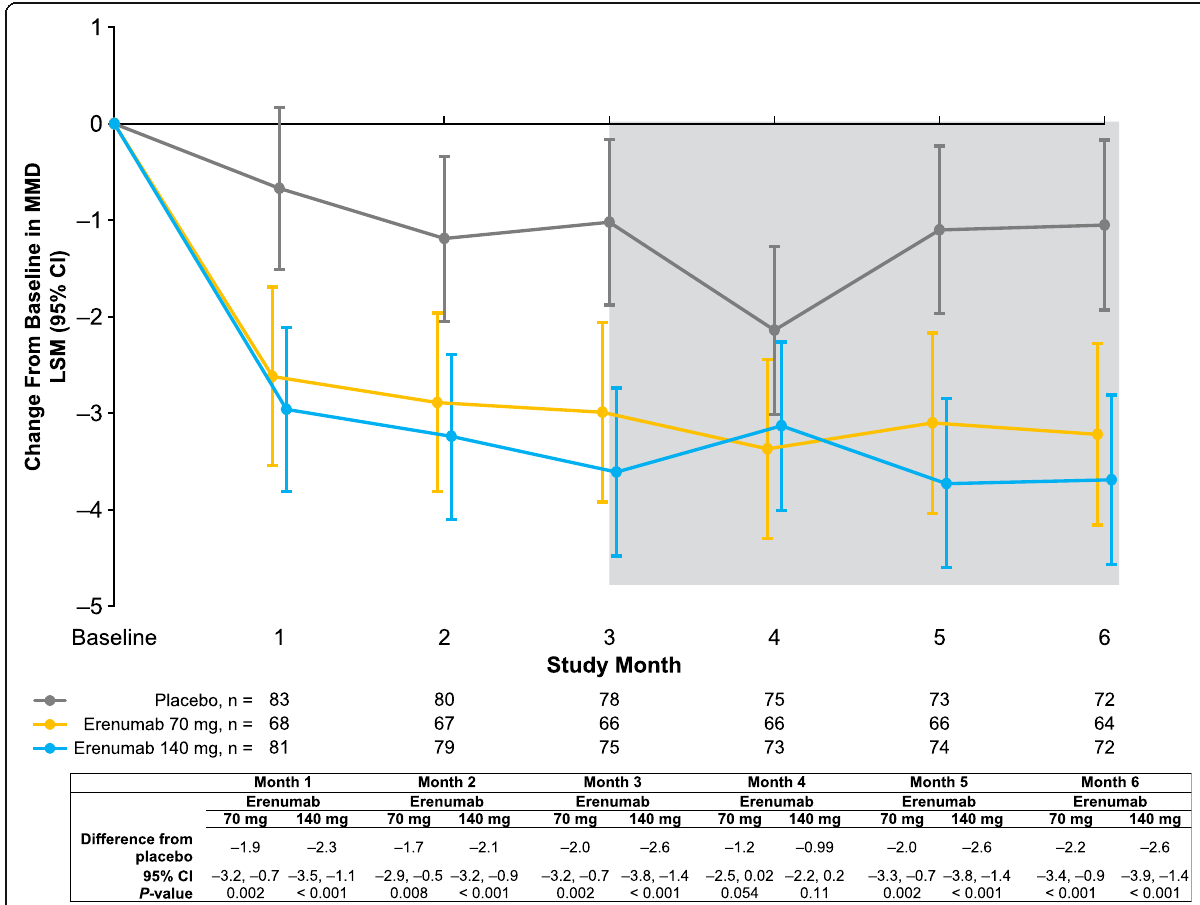
Fig. 1 Change from baseline in MMD. Data are shown as LSM with 95% CIs. The gray shaded area represents months 4 – 6. Abbreviations: CI, confidence interval; LSM, least squares mean; MMD, monthly migraine